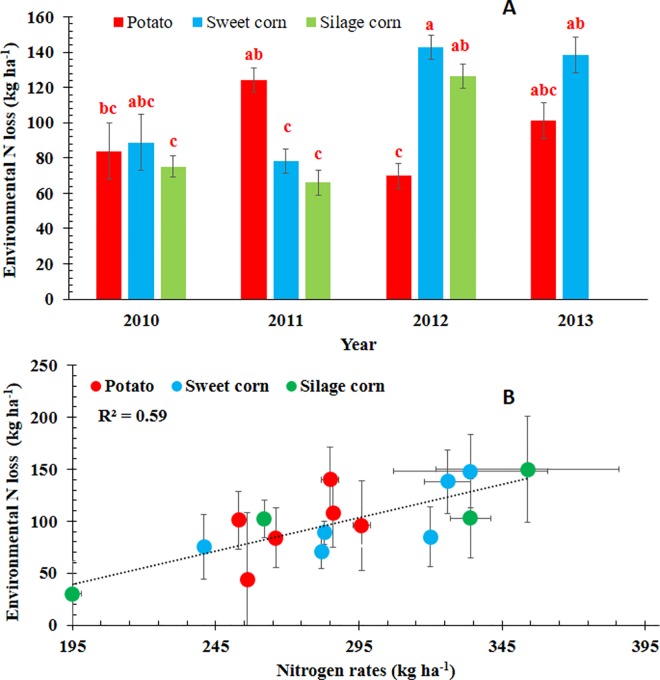
Comparison of A) environmental nitrogen losses (Nenvloss) from three crops (potato, sweet corn and silage corn) during four growing seasons (2010 to2013) and B) relationship between seasonal total N rates and environmental nitrogen losses at the study farm in the Middle Suwannee River Basin, Florida. Silage corn was not studied during 2013. Mean values of Nenvloss (represented by individual bars and their standard errors for the three crops) followed by different letters indicate significant difference at α = 0.05 level.